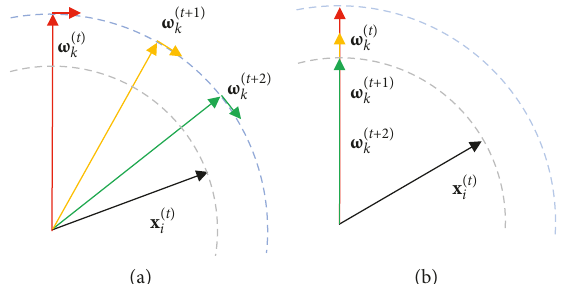
Figure 3: Convergence direction of GO loss, which is fixed in (a) the tangential and (b) radial directions during the optimization